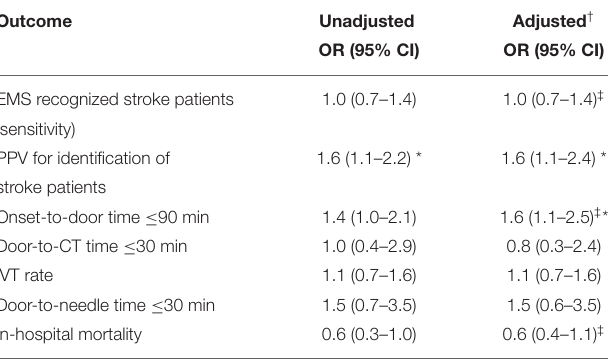
TABLE 4 | Logistic regression models showing the association between emergency medical services training and acute stroke care performance measure and hospital-based outcomes.